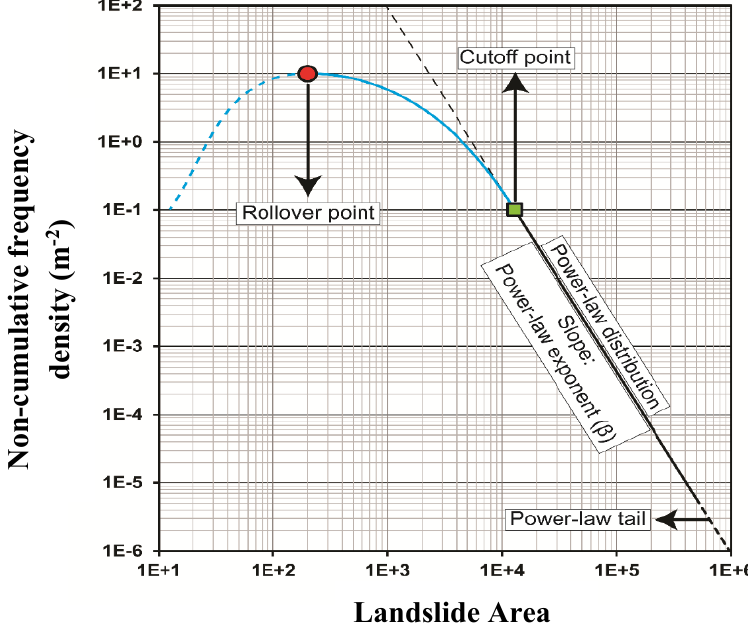
Figure 8. Schematic representation of the main components of a non-cumulative frequency area distribution (FAD) for a landslide inventory.